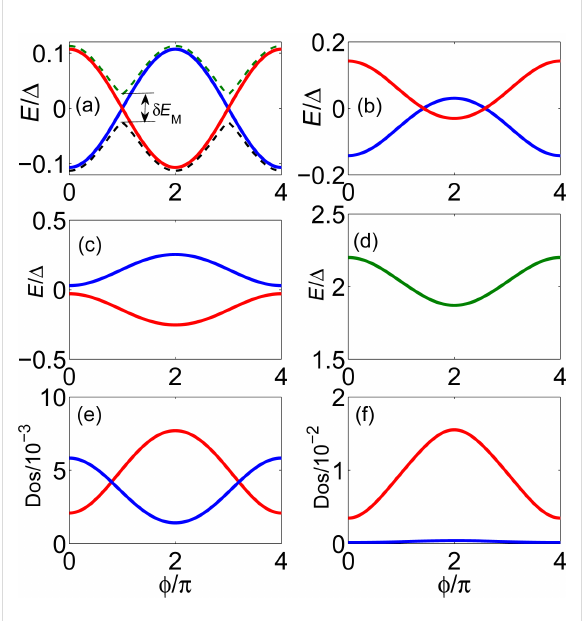
Figure 3: (a) For the Top-JJ shown in Figure 1a, when we consider the energy splitting induced by the finite length of the wire, the parity will be destroyed. The dashed line shows the energy spectrum versus the phase difference with L 1 = L 2 =100 a . A small gap δ E M can be ob- served due to the finite-length effect. (b) Energy spectrum as a func- tion of the flux in the ring structure with μ = − 2 t + 0.4 Δ and N x = 50 a . Here, E M = 0.05 Δ and Γ eff = 0.1 Δ . We can see that the gap is not opened and the 4 π period persists. (c) Energy spectrum as a function of the flux in the ring structure with μ = − 2t + 0.8 Δ and N x = 50 a . Here, E M = − 0.12 Δ > Γ eff . We can see that the two states of different parity are separated in energy space. (d) An energy spectrum that is beyond the superconducting gap in the ring structure and also oscillates with the 4 π period. (e) Flux-dependent DOS of the electron part (red solid line) and the hole part (blue solid line) along the odd parity state energy spectrum in panel (c). They are correlated with each other. (f) Flux-dependent DOS of the electron part (red solid line) and the hole part (blue solid line) along the energy spectrum in panel (d). They are not correlated with each other.